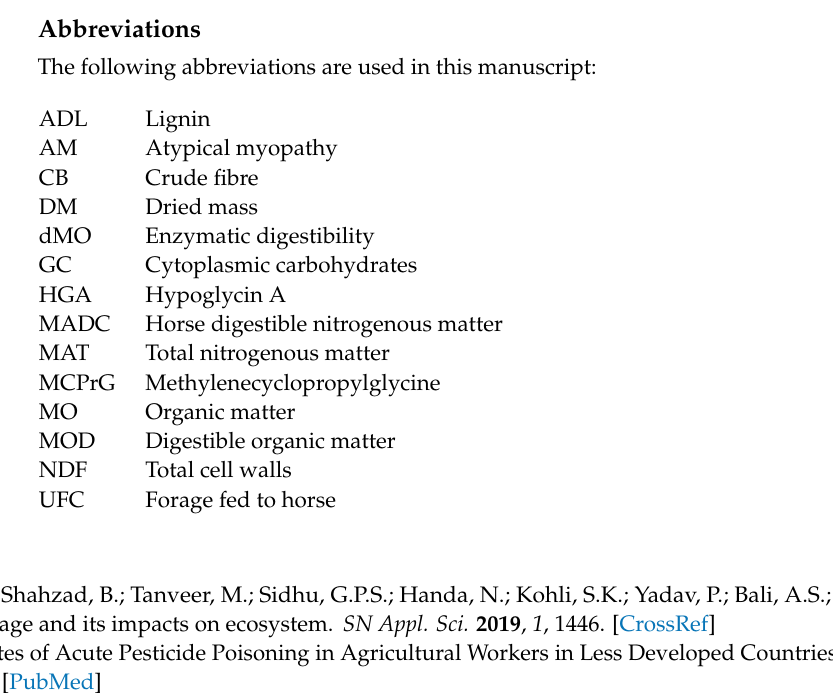
Table S8: Nutritional values of the harvest from experiment